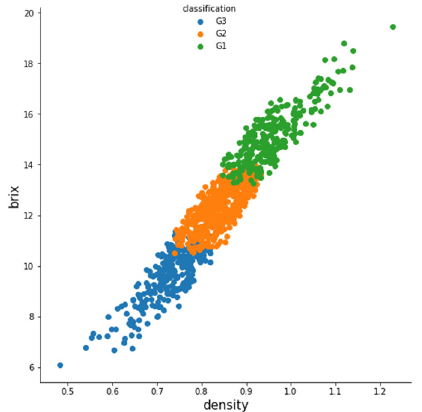
Figure 3. Relationship between sweetness and density.